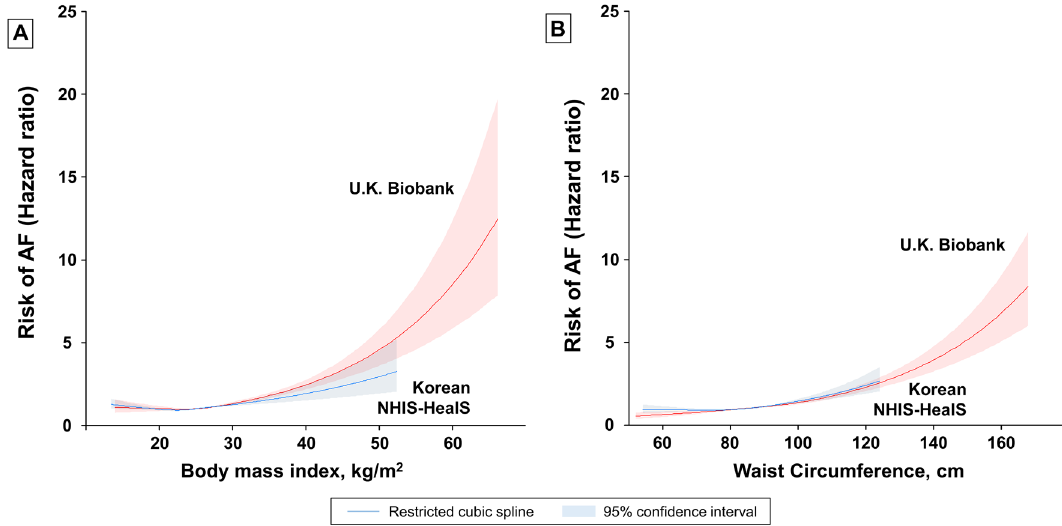
Figure 4. Spline curve of AF risk according to Body Mass Index ( A ) and waist circumference ( B ). ( A ) The trend of a rise in AF risk with increasing BMI was more prominent in the U.K. than Korea. ( B ) The trend of a rise in AF risk with increasing WC was more prominent in the U.K. than Korea. AF atrial fibrillation, NHIS- HealS National Health Insurance Service’s Health